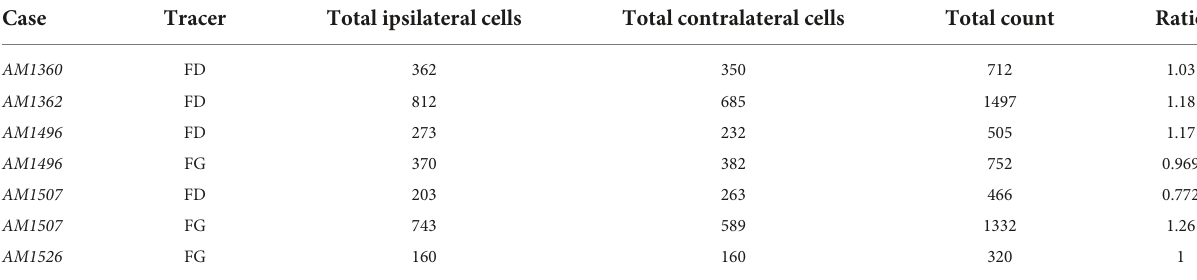
TABLE 3 Counts comparing the distribution between the ipsilateral and contralateral principal neurons of five cases.